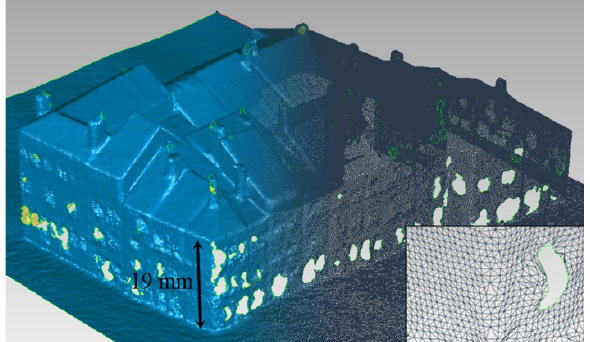
Fig. 5. Scan results for Toul replica scale model with resulting holes from non-captured black surfaces.